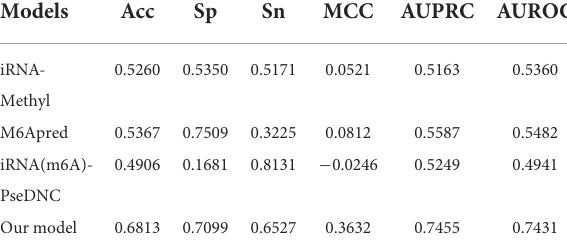
TABLE 6 Performance of different models on